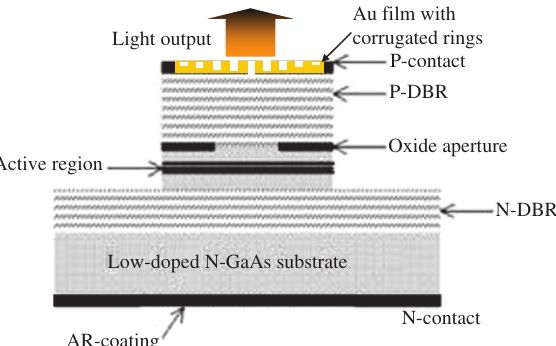
z­directions. Figure 2 is the beaming effect of the designed = 2 π / Λ in metalens at near field for the special case of k SP vertical planes of x­z and y­z, respectively. It can be seen that neither beam divergence nor convergence is observed in the near­field intensity distribution. To further check the beaming effect, we calculated the corresponding Figure 3. As can be seen, the beam spot size is nearly the Figure 5: Schematic diagram of integration of VCSEL and the metallic same along the propagation distance of several microns, structure, which is directly caped onto the emitting aperture of VCSEL. which is close to emitting surface, to as far as the distance Working wavelength of the VCSEL is 980